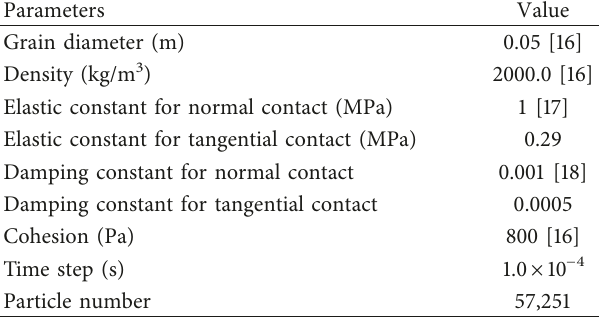
Figure 1: Calculation model [16]. Table 1: Calculation parameters.